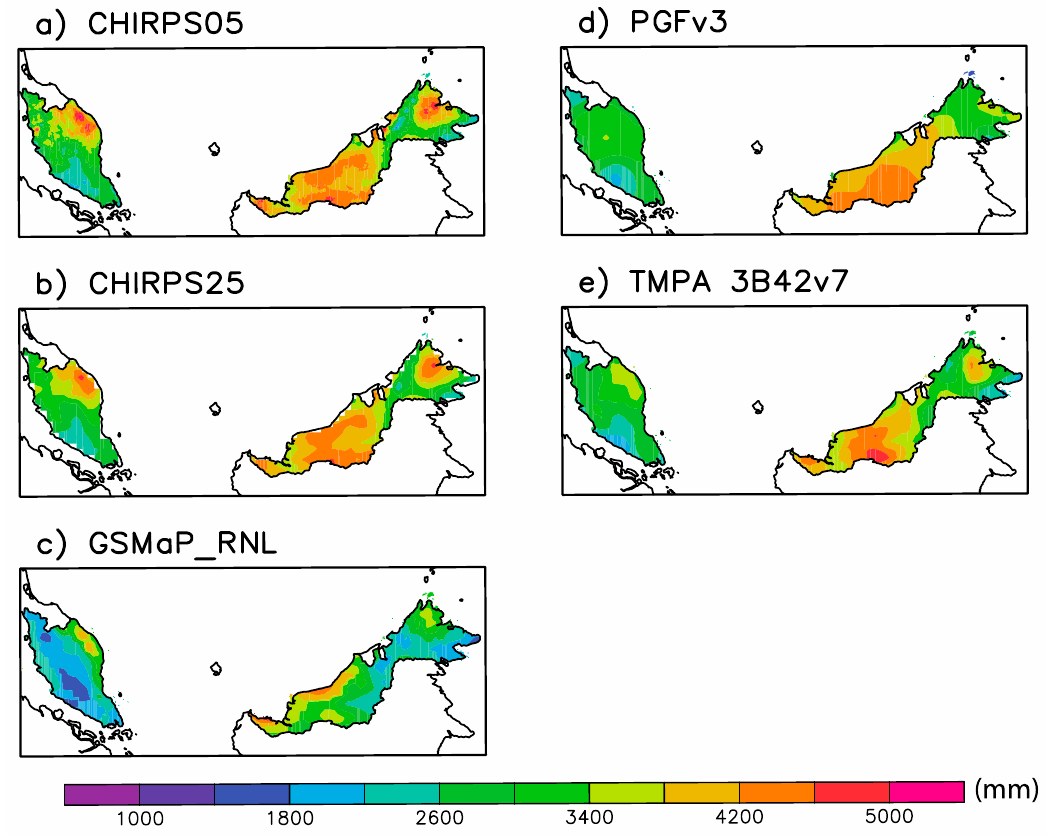
Figure 12. The spatial distribution of annual rainfall of all products. ( a ) CHIRPS05, ( b ) CHIRPS25, ( c ) GSMaP_RNL, ( d ) PGFv3, ( e ) TMPA 3B42v7.